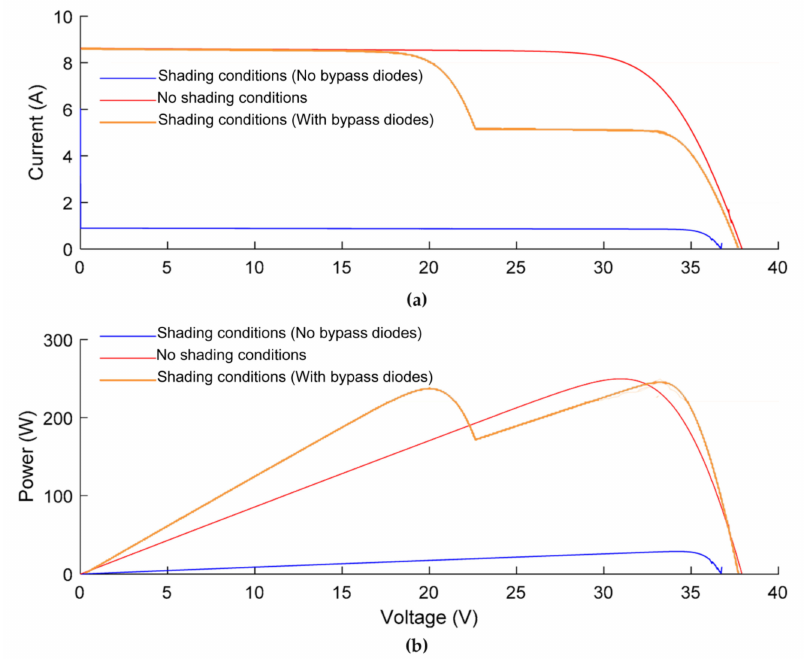
Figure 2. An example of reducing partial shading effects with bypass diodes: ( a ) I-V curves; ( b ) P-V curves. Reproduced from [27], MDPI: